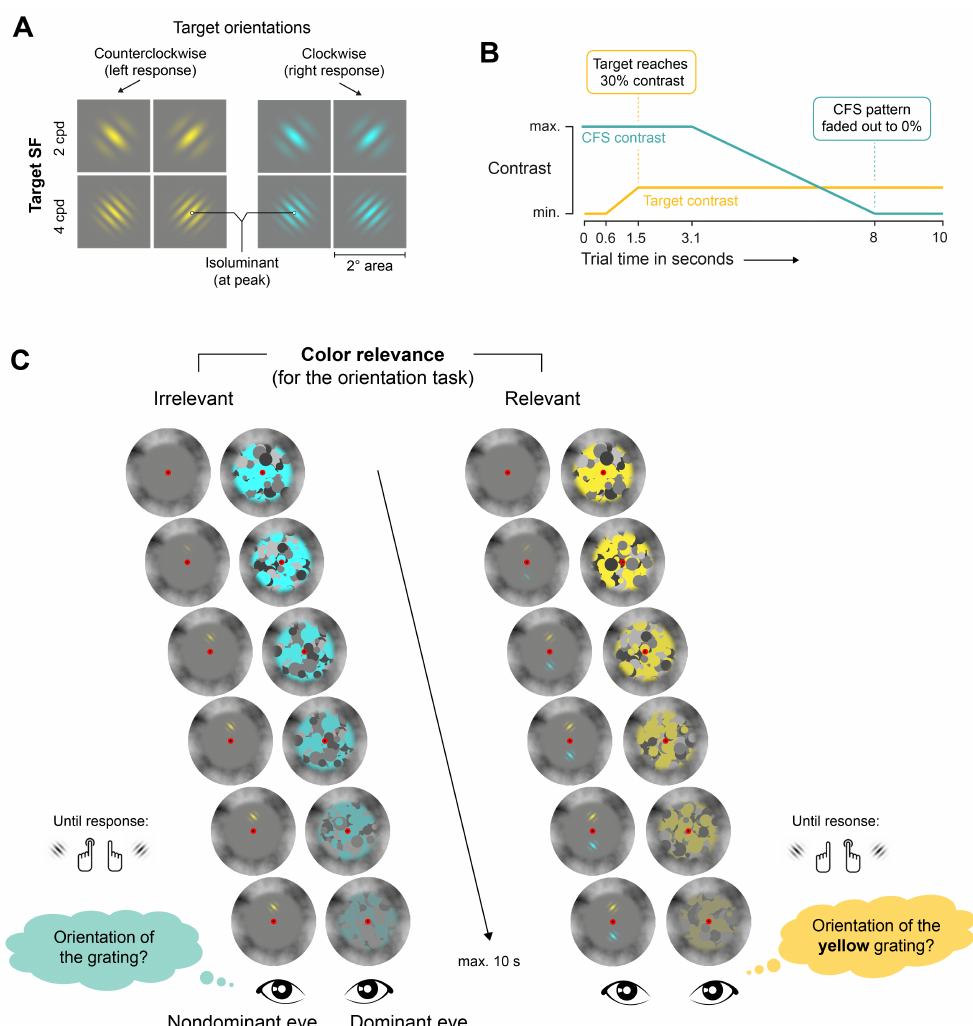
Figure 1. ( A ) Targets were counterlockwise or clockwise rotated Gabor gratings presented above or below the fixation point. Targets had a SF of 2 cpd or 4 cpd and were rendered either in yellow or cyan. Colors were isoluminant at their peak luminance values. ( B ) The target grating’s contrast was ramped up in the first phase of the trial, while the contrast of the CFS masks decreased over time in the second phase of the trial. The trials had a maximum duration of 10 s but ended as soon as the participants gave a response. ( C ) The targets were delivered to the non-dominant eye using a mirror stereoscope. Perception of the targets was interocularly suppressed by presenting a random sequence of CFS masks with a 10 Hz update frequency to the dominant eye. The targets had either the same or different color as the CFS masks. The color of the CFS masks varied randomly between cyan and yellow from trial to trial. In each trial, the participants’ task was to report the target’s orientation using key presses as soon as they could perceive it. As soon as the participants responded, the trial ended. Left: in the color irrelevant block, only one grating was presented in each trial, which varied randomly between cyan and yellow from one trial to the next. Right: In the color relevant block, two gratings were presented in each trial, and participants reported gratings that matched the instructed target color (either yellow or